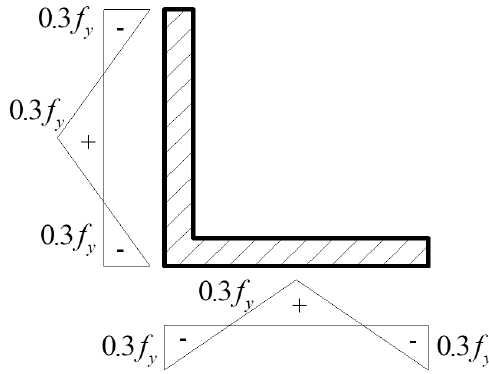
Figure 14: Distribute form of residual stress